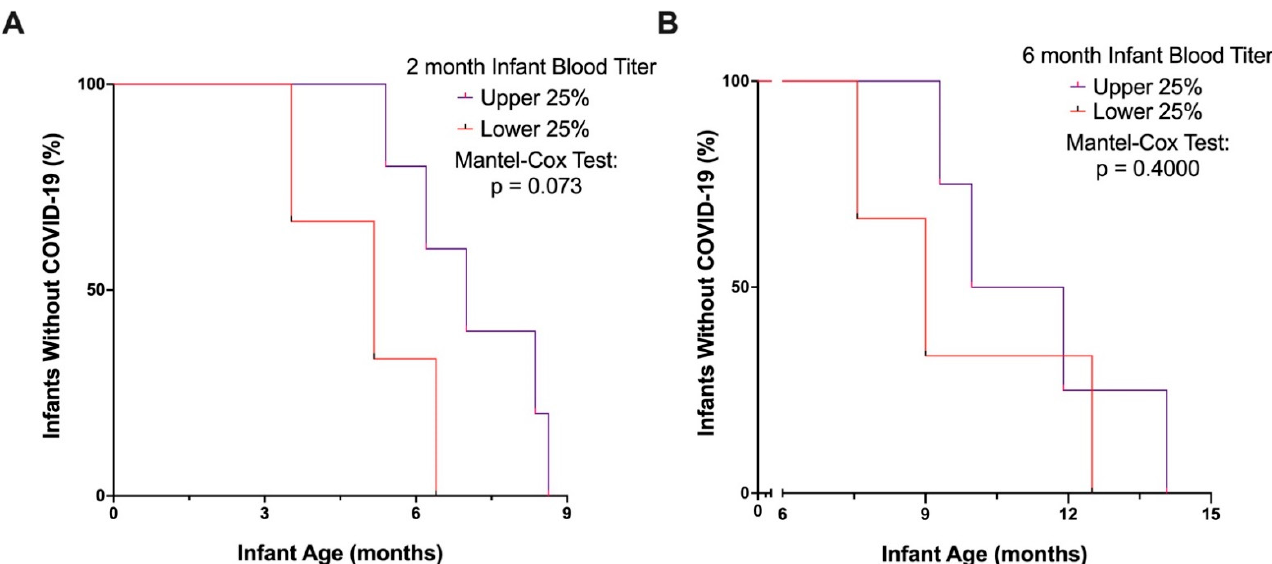
Figure 2. Relationship between infant 2-month and 6-month antibody titers and SARS-CoV-2 infec- tion. Anti-Spike titers were measured in two- and six-month-old infants who were born to COVID-19 vaccinated individuals. ( A ) Kaplan–Meier curve displays time to SARS-CoV-2 infection for infants who developed COVID-19 through 9 months of age, grouped by those with high (upper 25%) and low (lower 25%) anti-Spike IgG titers in blood at two months of age ( B ) Kaplan–Meier curve displays time to SARS-CoV-2 infection for infants who developed COVID-19 after six months of age, grouped by those with high (upper 25%) and low (lower 25%) anti-Spike IgG titers in blood at six months of age. Analyses performed by a Mantel-Cox